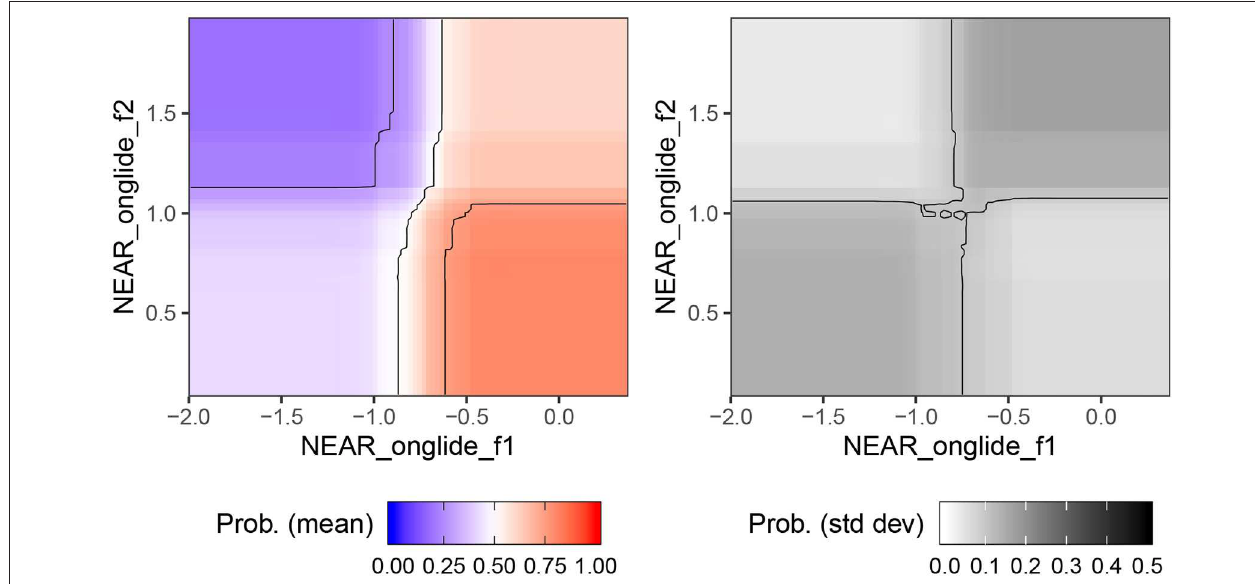
FIGURE 4 | Certainty of the random forests predicting Manchester based on F1 and F2 of NEAR measured at onglide.